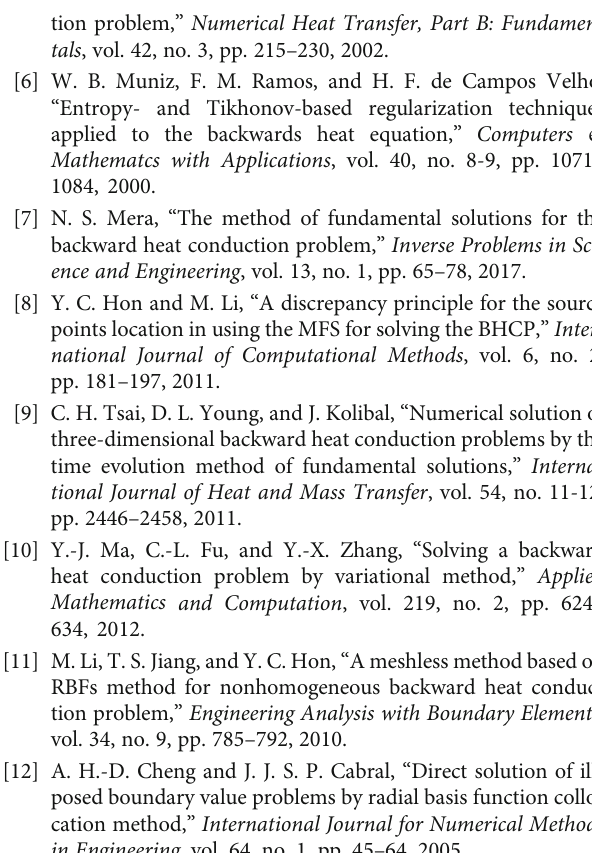
Figure 8: The numerical solution for the initial temperature u ð x , 0 Þ obtained for t for example